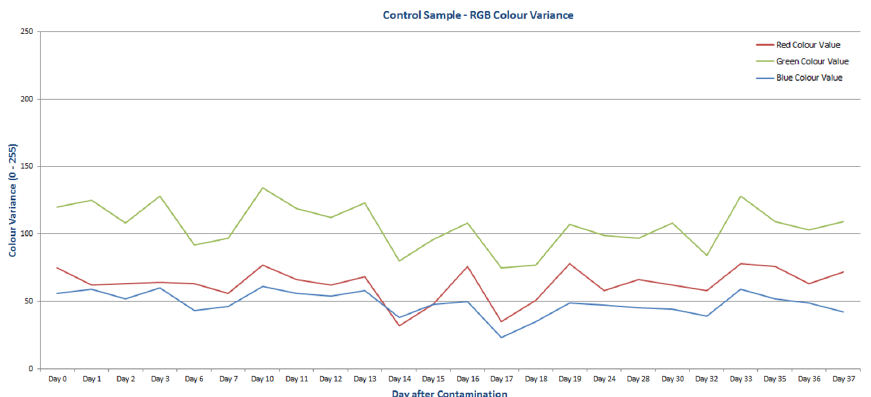
RGB colour values plotted as a function of